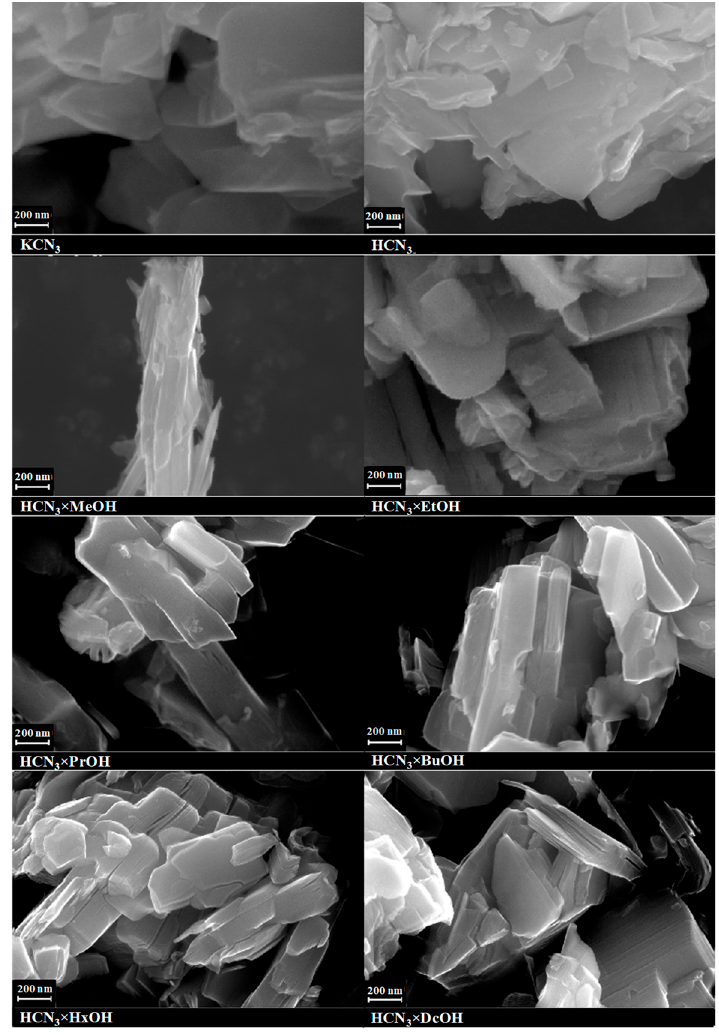
Figure 5. SEM images of the initial niobates and their n -alkoxy